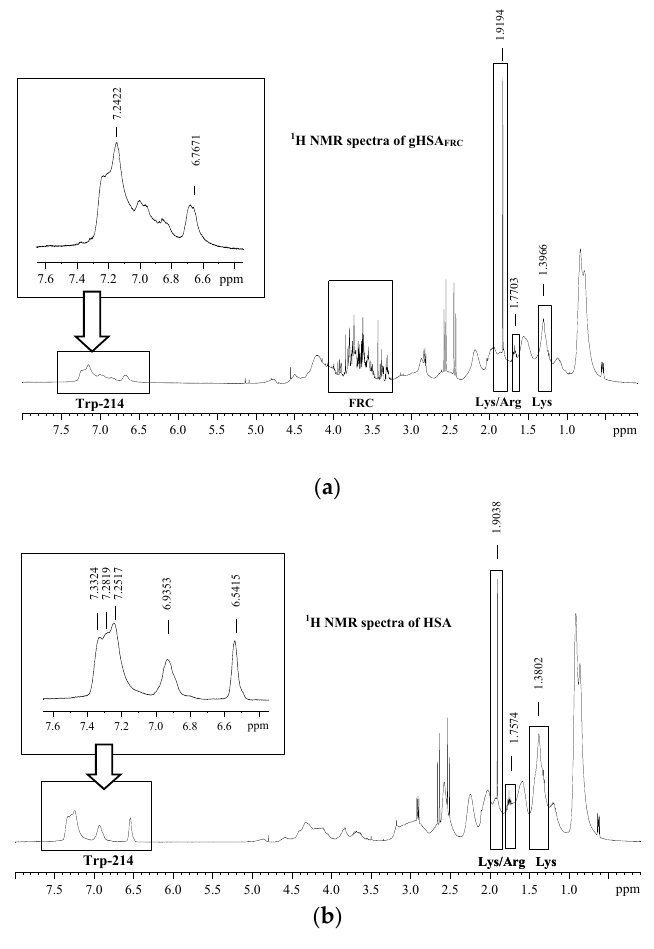
Figure 9. 1 H-NMR spectra of ( a ) glycated (gHSA FRC ), ( b ) non-glycated (HSA), protein concentration equals to 1 × 10 − 3 mol ∙ L -1 ; t = 37 °C. 1 H-NMR spectra of HSA come from our previous study [42].